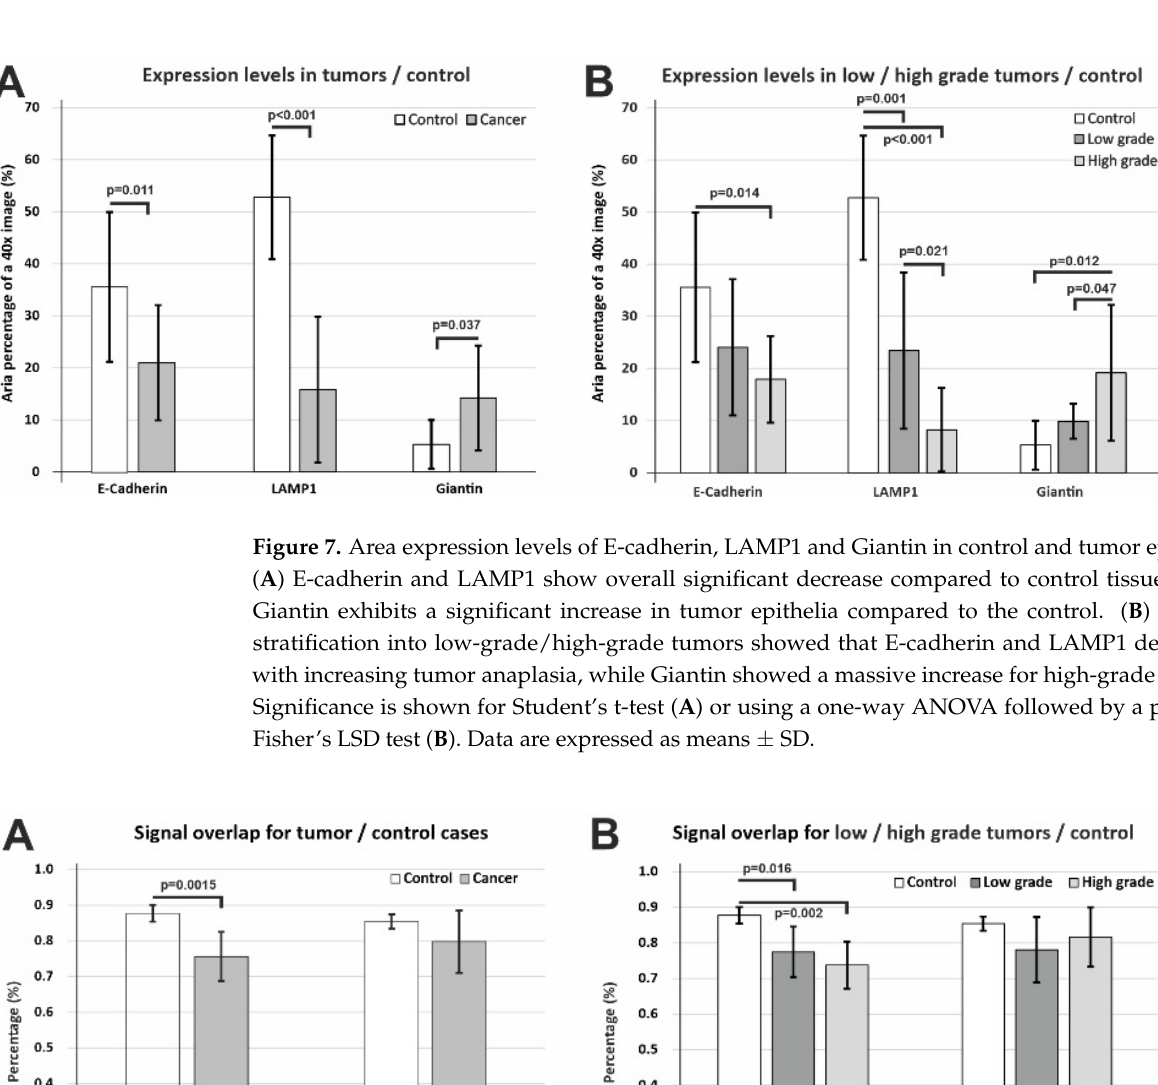
8 of 17 Figure 6. Exemplary deconvolved working images of double immunofluorescence for E-cadherin and LAMP1. Epithelia of control tissue ( A – C ), low-grade ( D – F ) and high-grade ( G – I ) adenocarci- noma were analyzed for expression area and LAMP1/E-cadherin overlap. In image G the dotted line illustrates how epithelia was selected as the region of interest for further analysis; colocaliza- tions are indicated (arrows) at both membrane and sub-membrane and cytoplasmic levels. Scale bar for images A–C, D–F and G–I, 10 μ m.